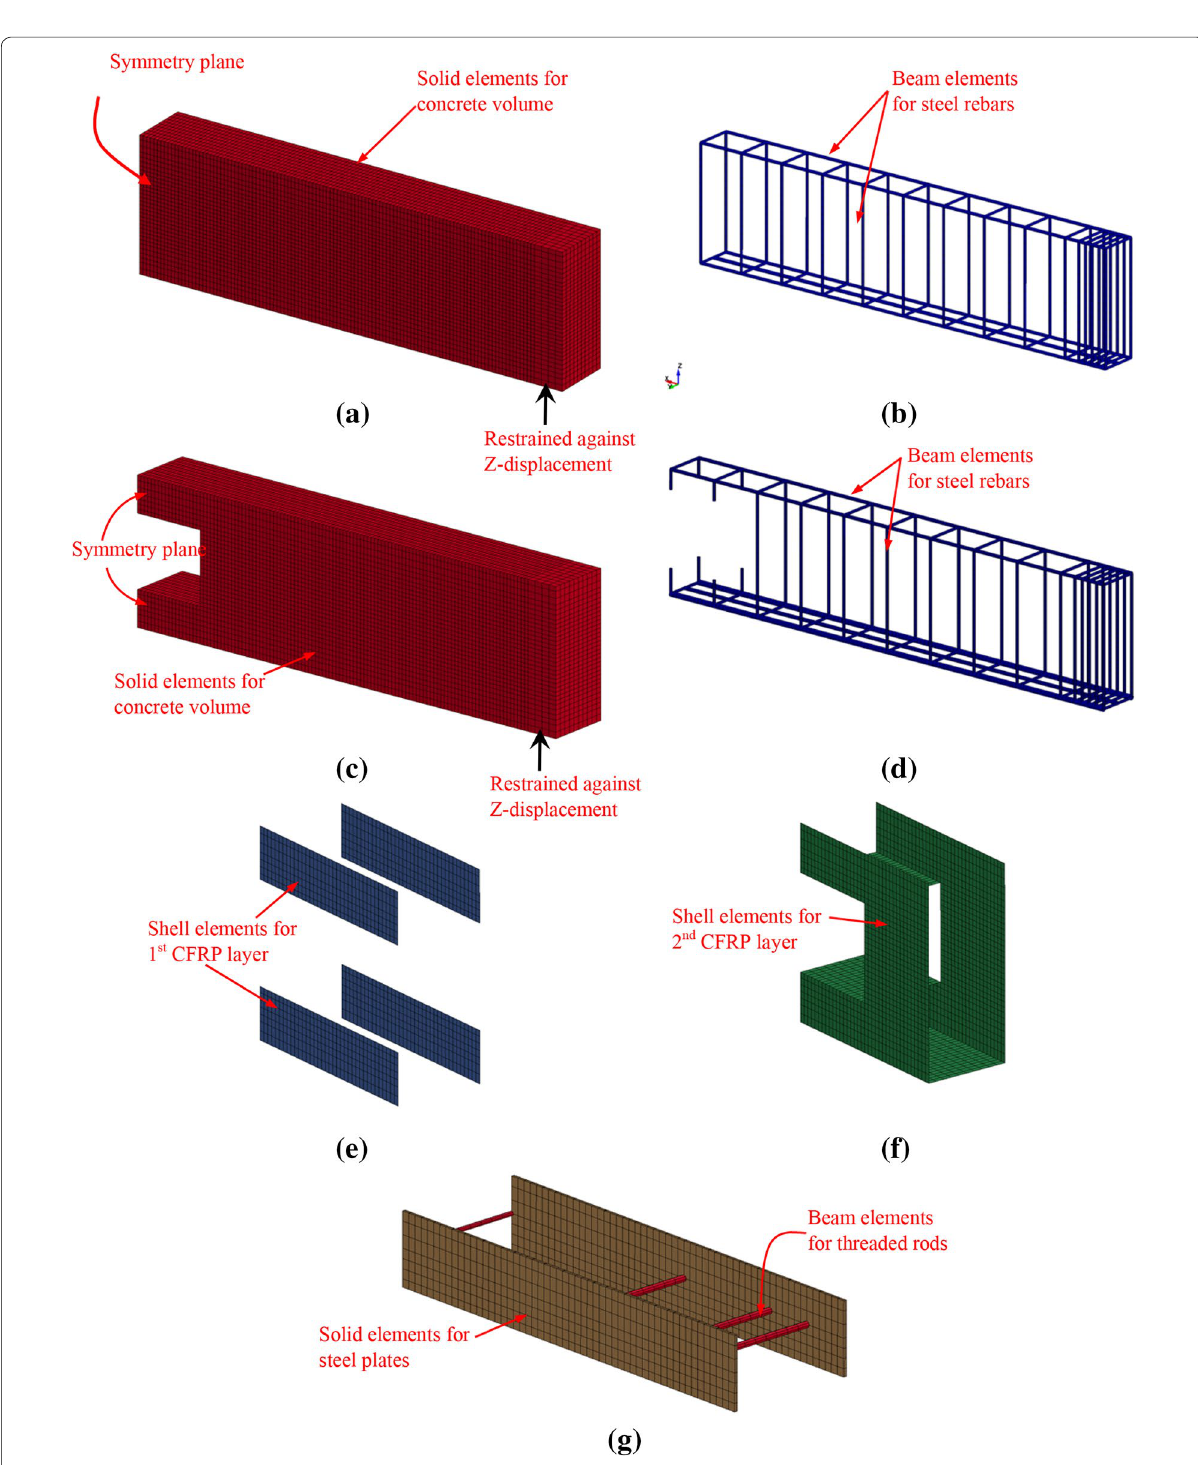
Fig. 11 FE model for one‑half of specimens: a concrete volume for BC‑N‑4PB and BC‑N‑CPL, b steel rebars for BC‑N‑4PB and BC‑N‑CPL, c concrete volume for BC‑O1‑4PB and BC‑O1‑CPL, d steel rebars for BC‑O1‑4PB and BC‑O1‑CPL, e 1st CFRP layer for BS1‑O1‑CPL, f 2nd CFRP layer for BS1‑O1‑CPL, and g steel plates with rods for